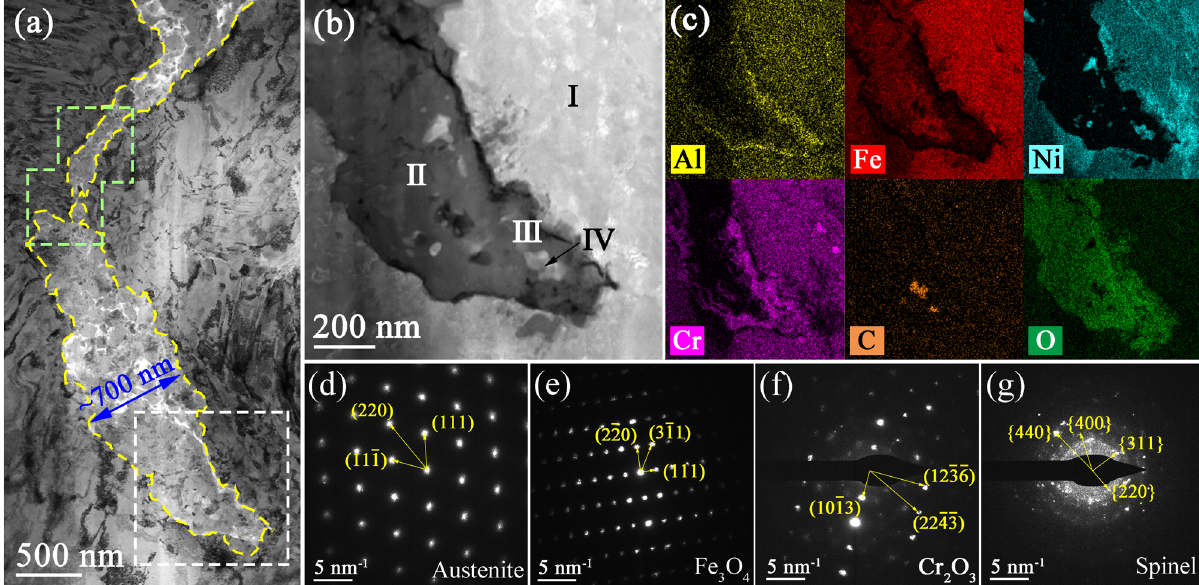
Fig. 12 TEM results of the crack tip of A2 sample (3.5Al – 0.6Nb). a BF image, b HAADF image inside the white frame, c EDS mapping of ( b ), d – g nanobeam diffraction patterns of I, II, III and IV regions labeled in ( b ).